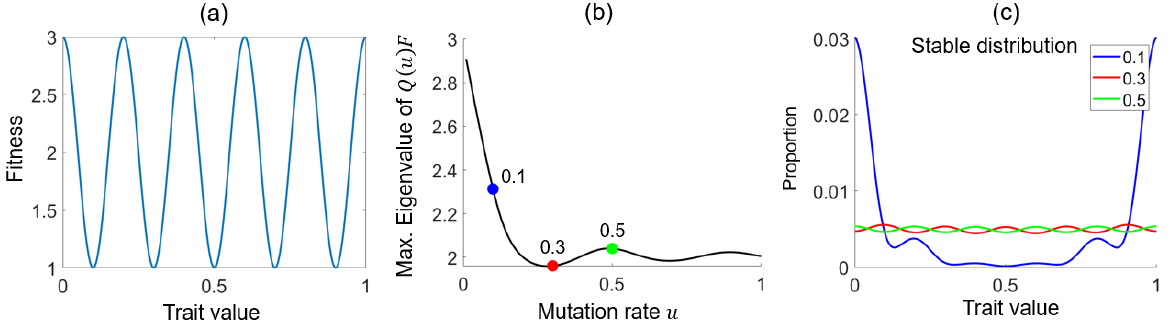
Figure 4. A periodic fitness function f ( x ) = cos ( 10 π x ) , shown in ( a ), can lead to oscillations in the maximum eigenvalue, ( b ), creating both stable and unstable equilibria. The stable distributions, ( c ), are mostly periodic, though they peak around the boundary for low mutation